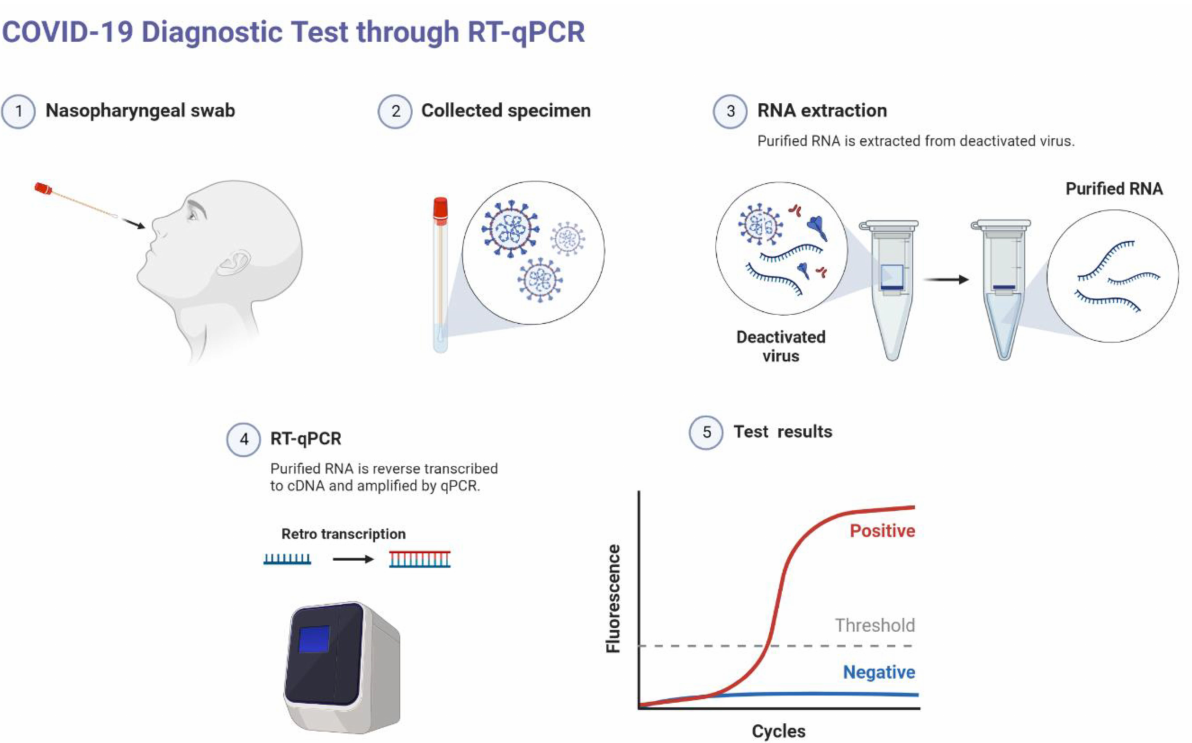
Figure 1. SARS-CoV-2 diagnosis by nucleic acid amplification method, qRT-PCR. ( 1 , 2 ). Nasopha- ryngeal swabs were taken from the patients. ( 3 ). RNA extracted/purified by RNA purification kit. ( 4 ). Extracted RNA is reverse transcribed to complementary DNA and amplification using the target-specific primers. ( 5 ). Quantitative real-time PCR (qRT-PCR) to identify the positive samples. Conducted to identify positive samples in real-time from the fluorescence of the dsDNA intercalating dyes such as SYBR